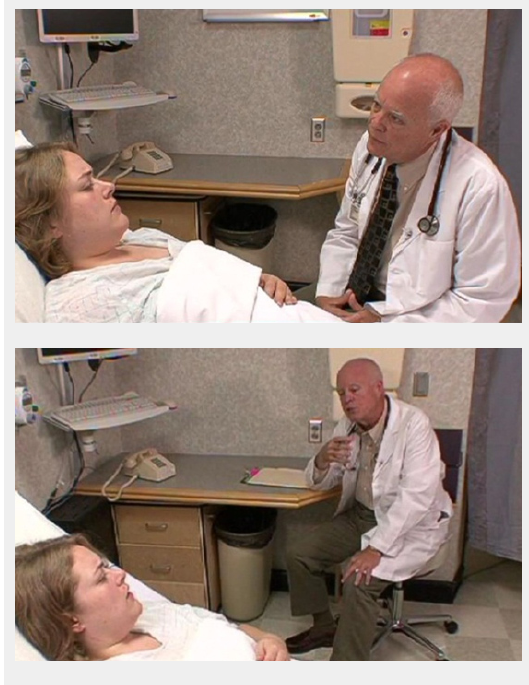
Screenshots of the error disclosure video vignettes. (1.) Competent error disclosure; (2.) incompetent error